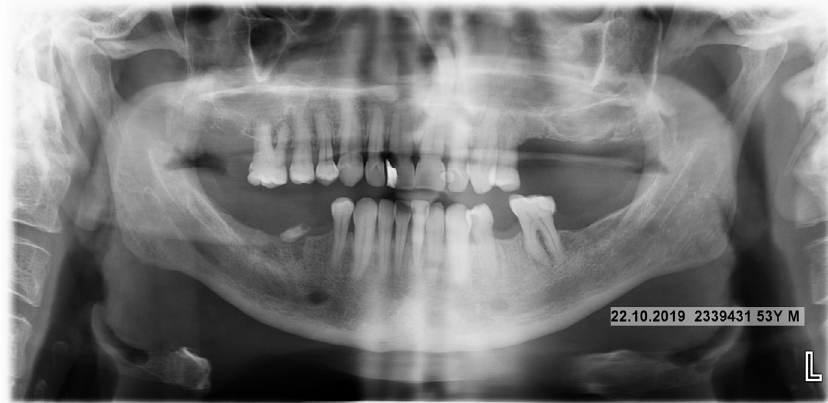
Fig. 2. Panoramic radiograph showing complete obliteration of bilateral maxillary sinuses.